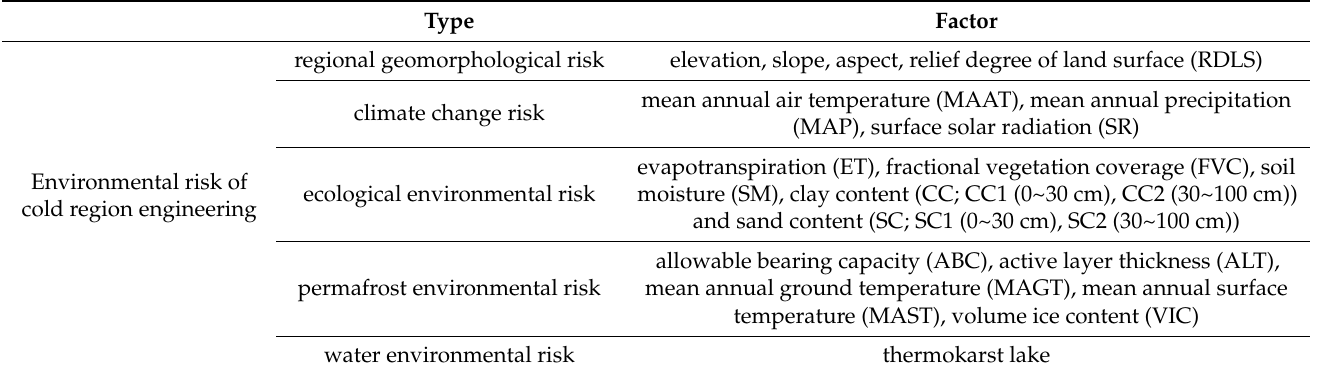
Table 1. Initial identification of risk